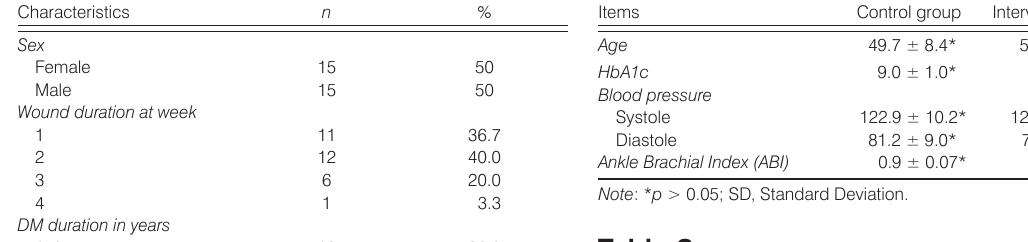
Table 2. Differences between control group and intervention group